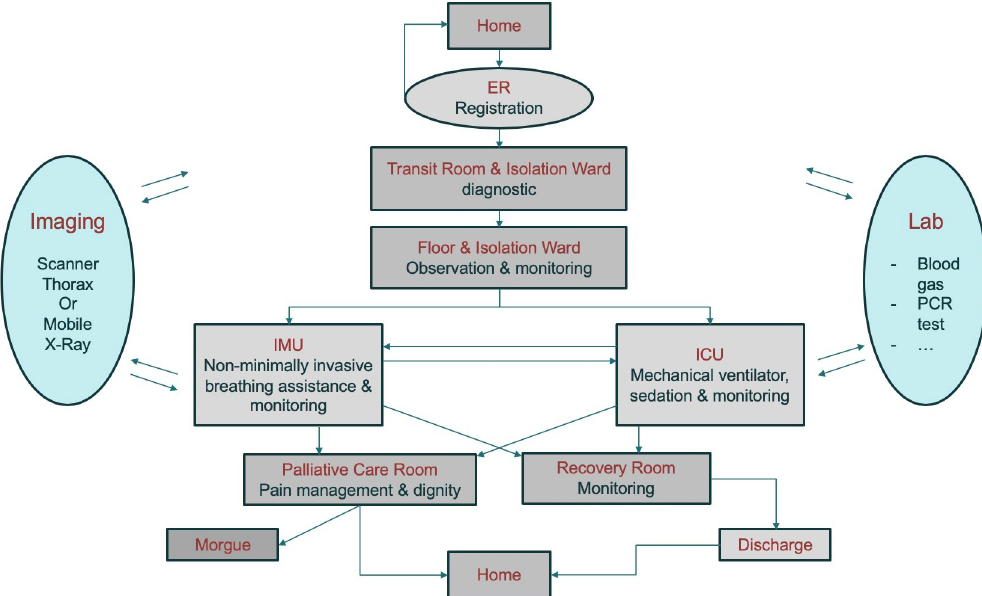
Fig 1. Workflow used in the model to follow patient progression in the hospital.